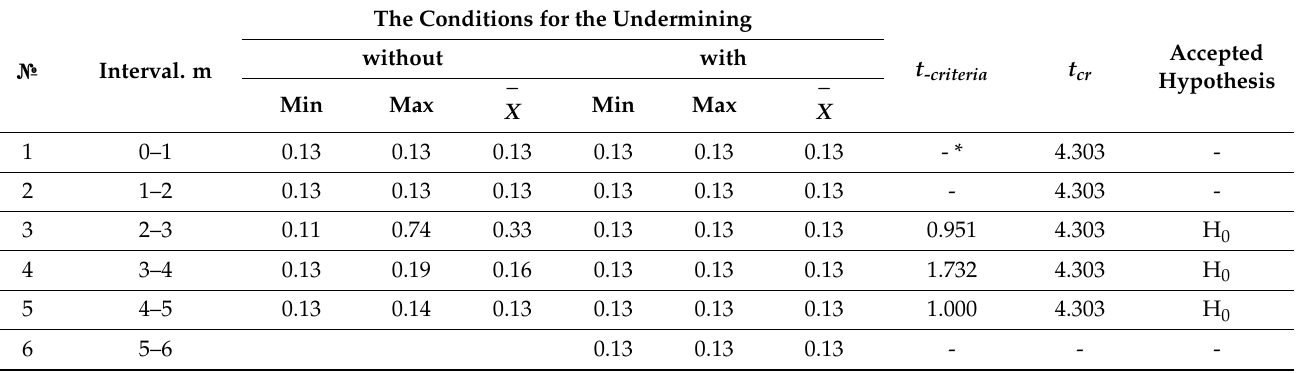
Table 2. The results of the statistical analysis of the experimental studies of the free gas content of the drift floor.